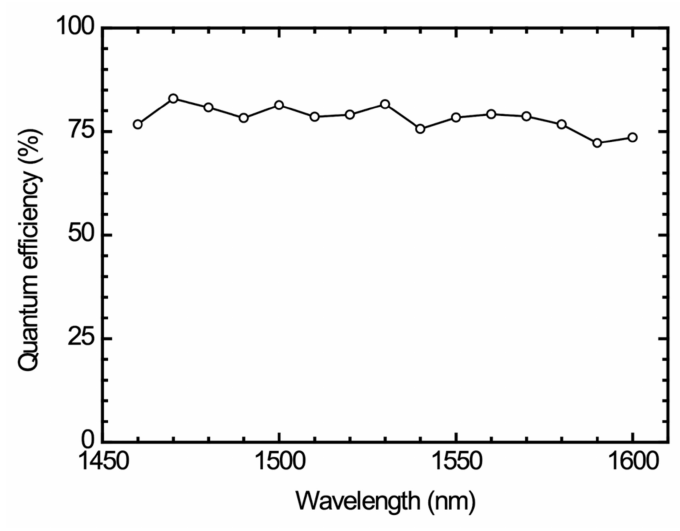
Figure 12. Quantum efficiency as a function of wavelength.